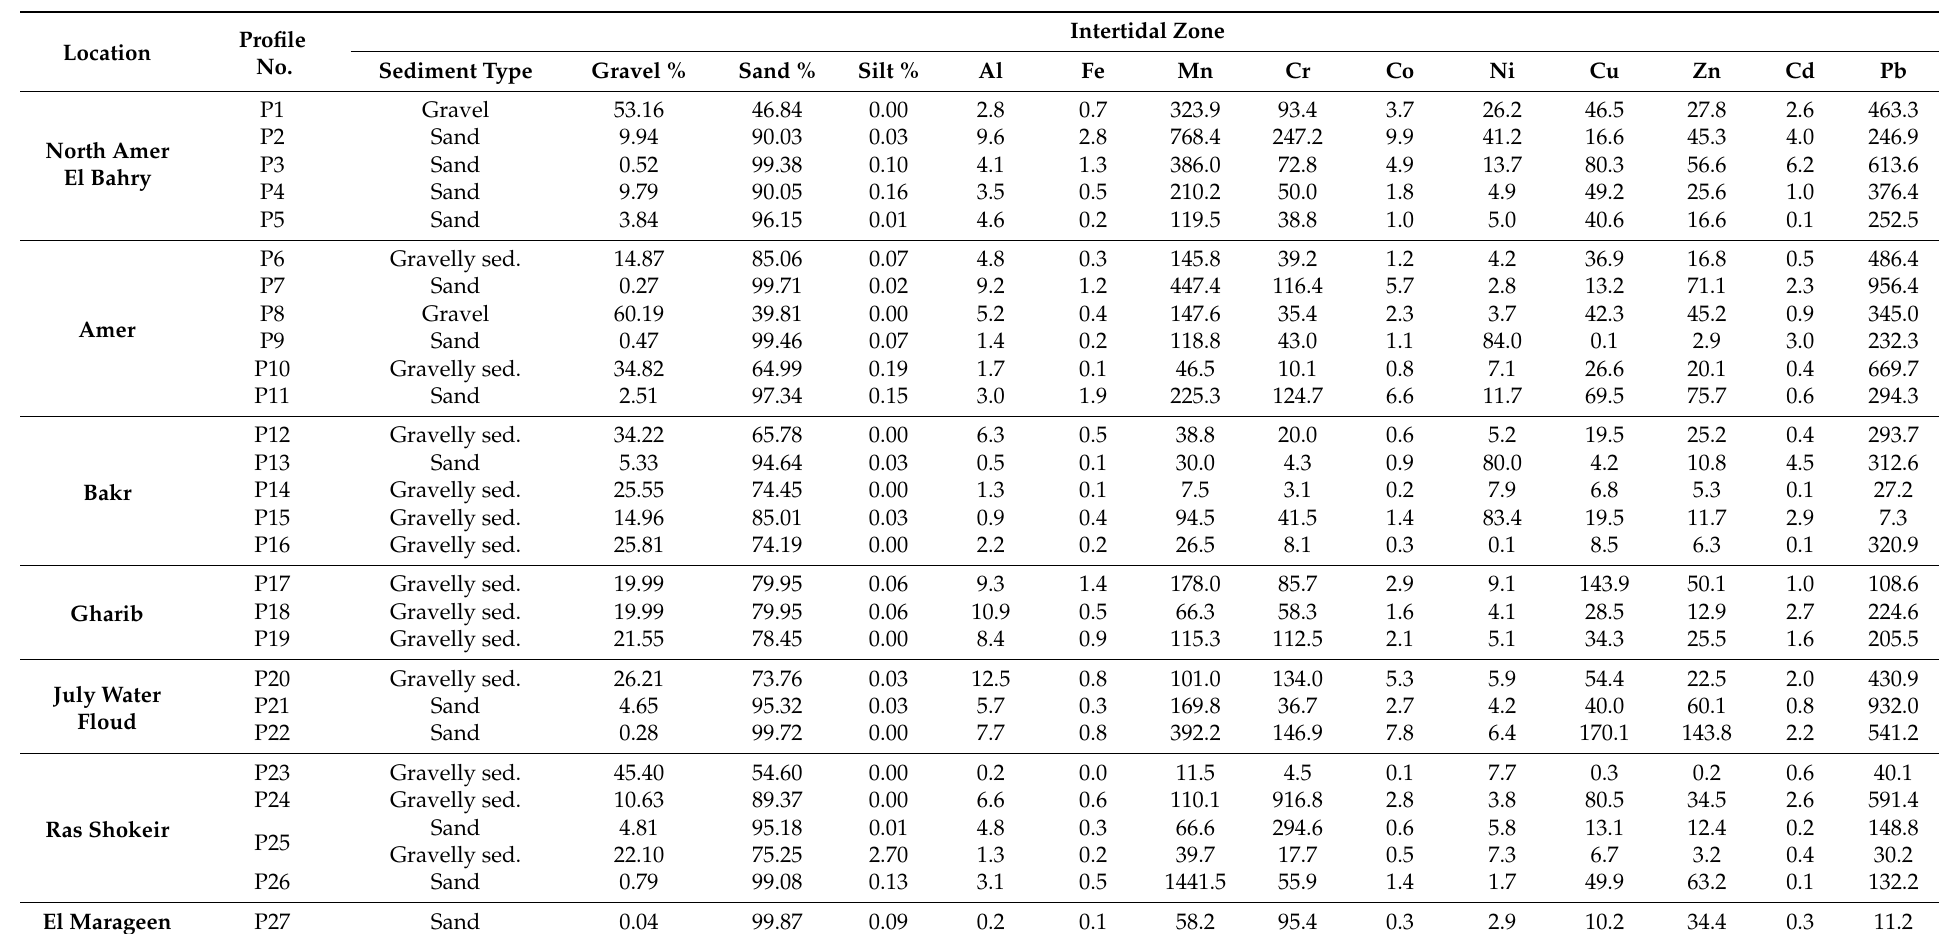
Table 3. Sediment types and concentrations of heavy metals in ppm, except for aluminum and iron, which are in %.